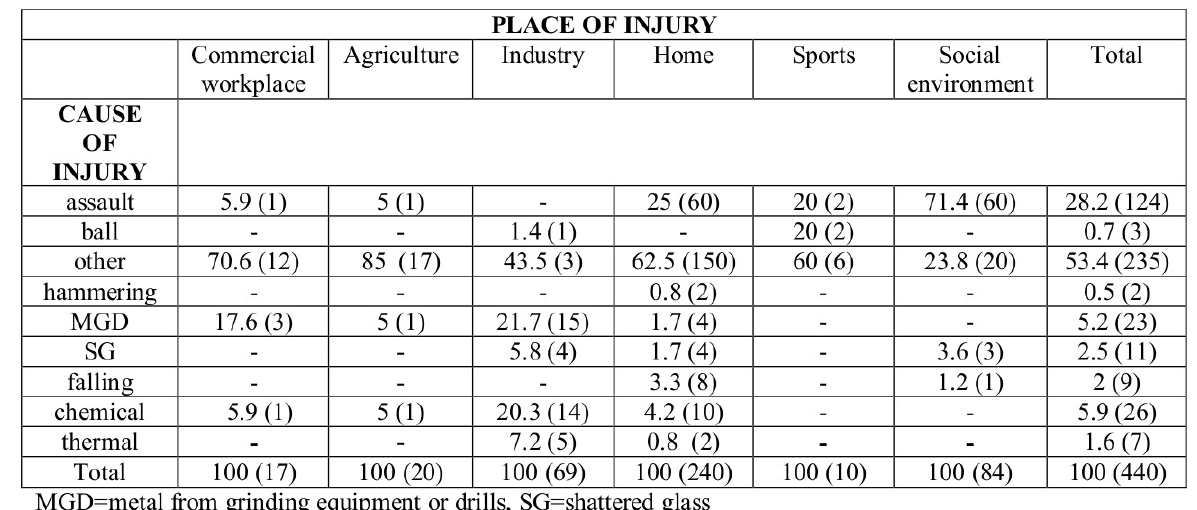
Table 2 . Cause of injury (columns: % ( n )) in relation to place of injury